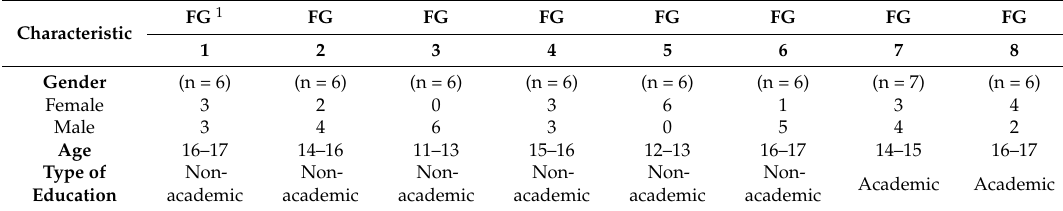
Table 2. Characteristics of the focus groups.